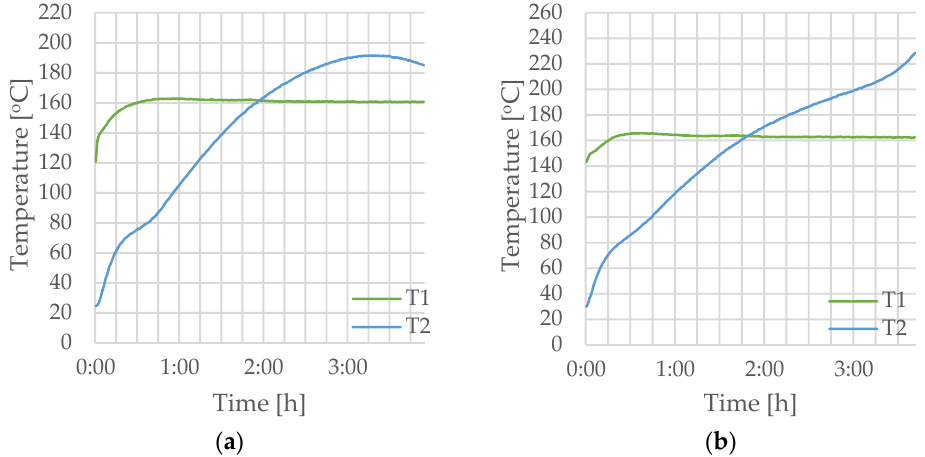
Figure 8. The temperature of sludge pellets in a 50.27 cm 3 basket: ( a ) at a furnace temperature of 170 °C with no evidence of dust ignition, ( b ) at a furnace temperature of 172 °C with a dust ignition.